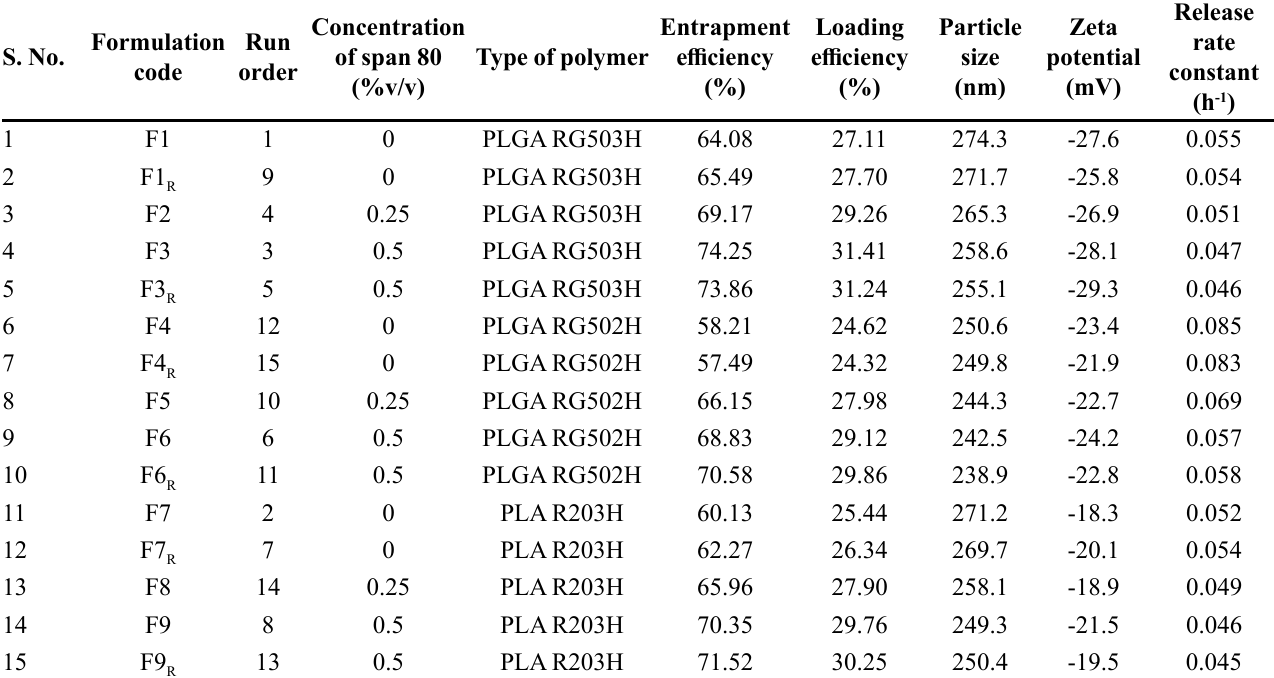
TABLE I - Combinations of the selected factors according to the design and the obtained results of TDF-ACNs